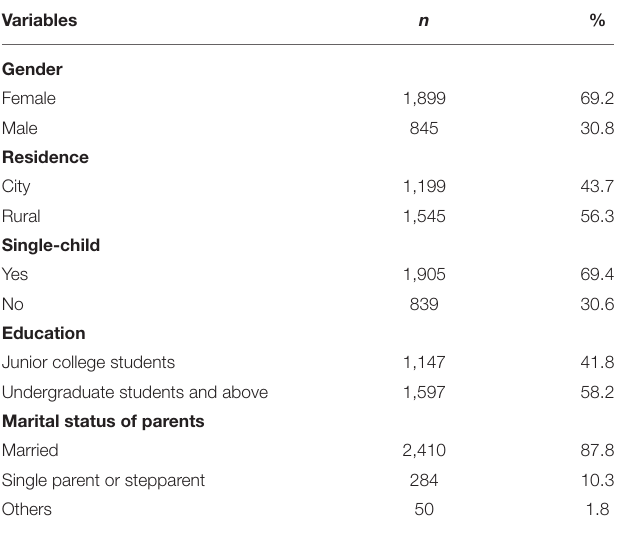
TABLE 1 | General characteristics of the participants ( n =